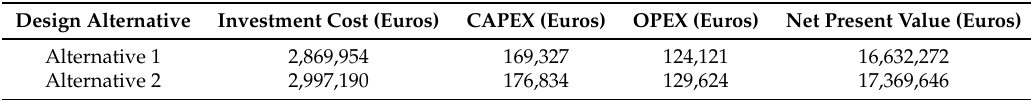
Table 7. LCC calculation results for the running